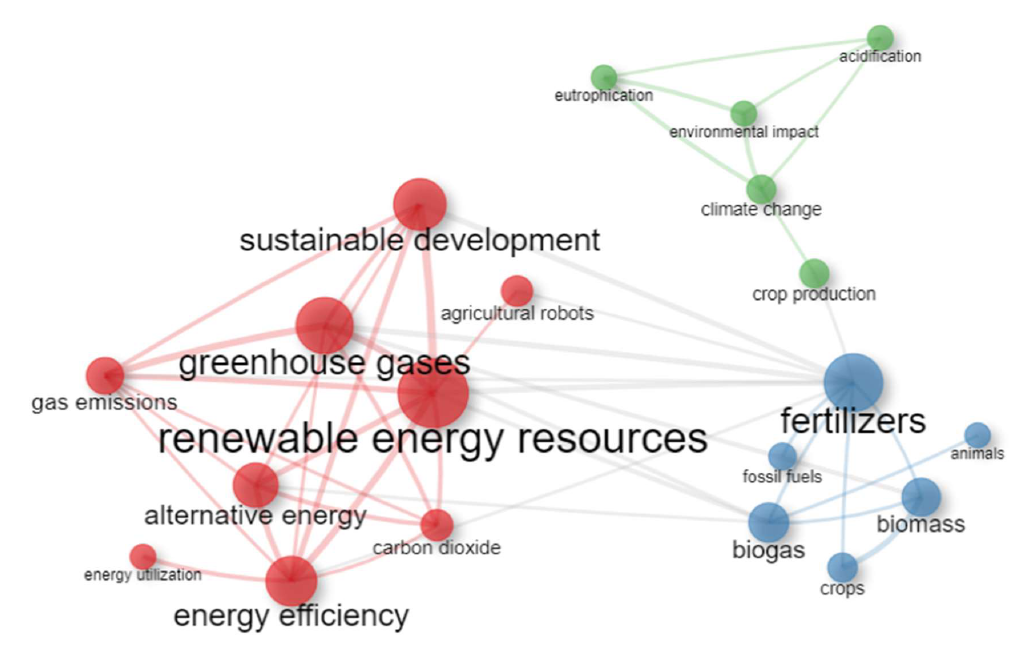
Figure 5. Keyword co-occurrence network (2019–2022). Source: created by the authors.